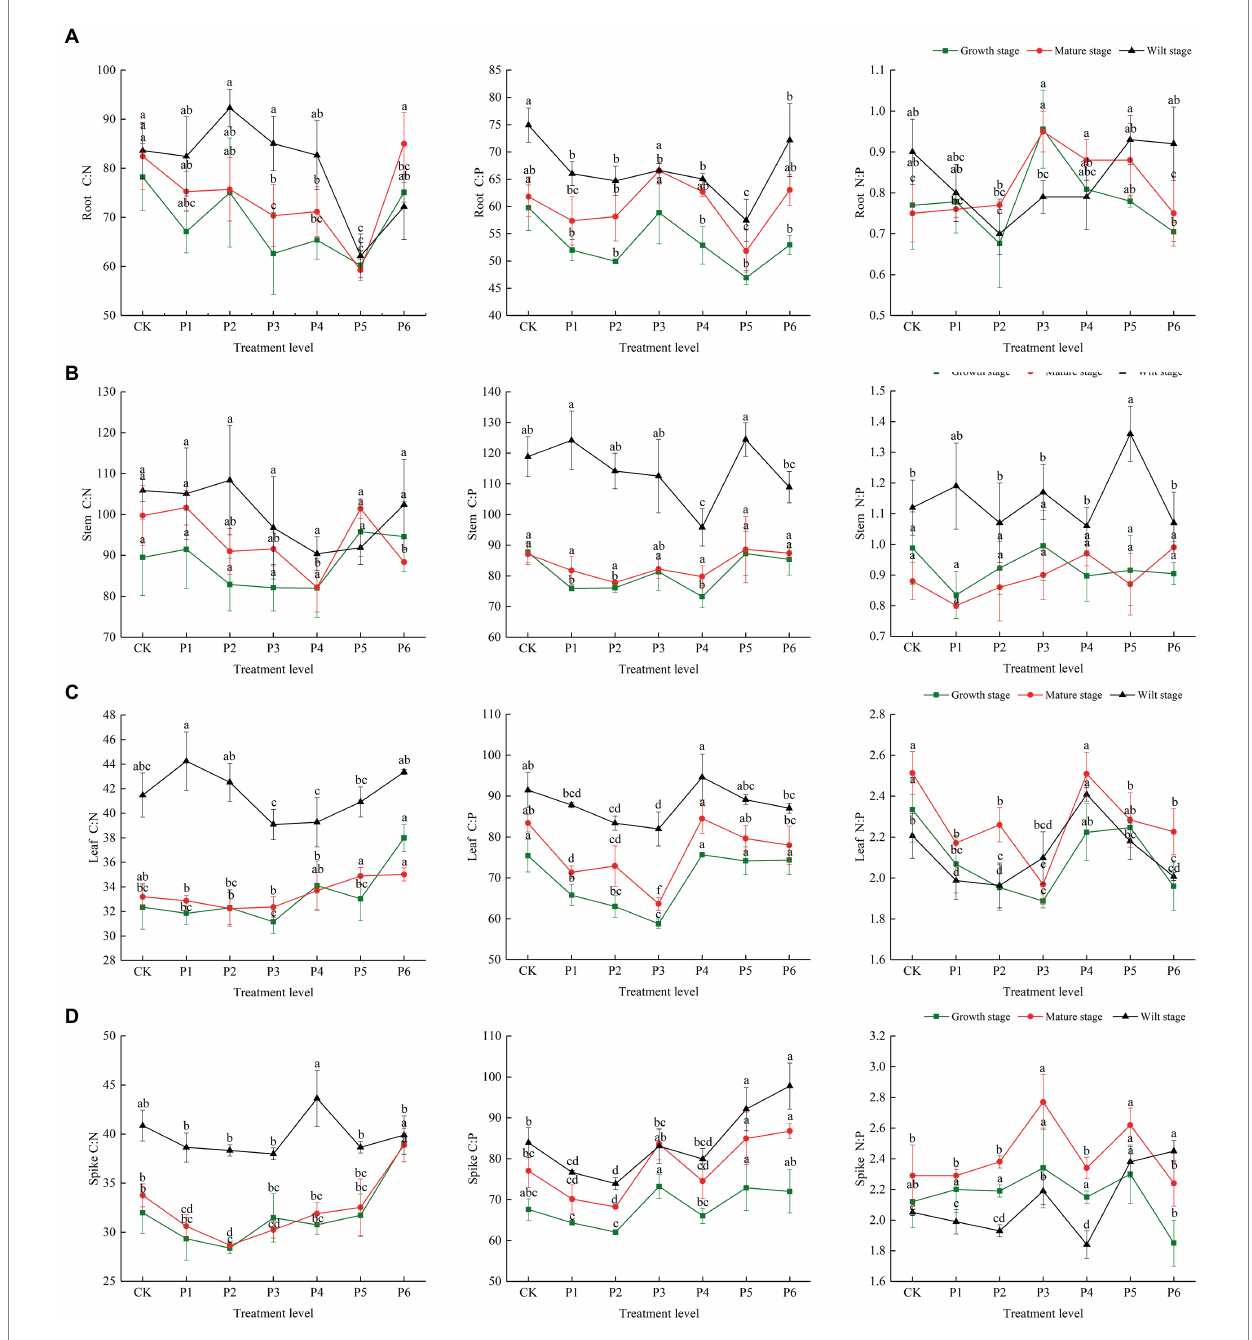
FIGURE 2 The effect of P fertilizer gradient addition on C/N, C/N, and N/P in different organs ( A , root; B , stem; C , leaf; D , spike) at different growth stages of bluegrass. Different lowercase letters indicate significant differences among different phosphorus additions at p <